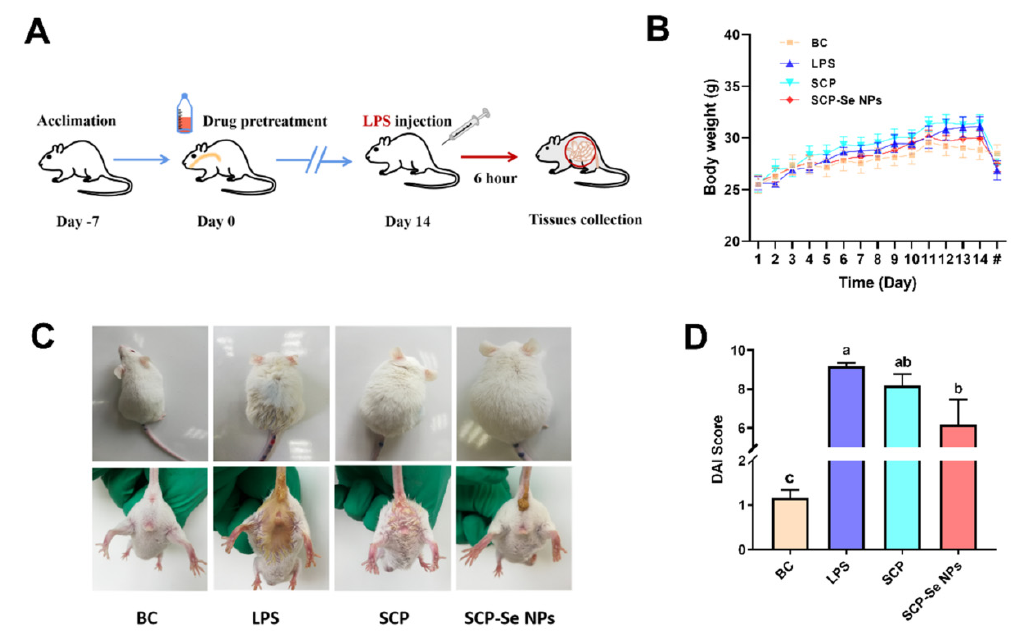
Figure 8. Effects of SCP-Se NPs on LPS-induced enteritis in mice. ( A ) Flow chart of animal experiment. ( B ) Body weight changes of each group during the experiment. “#” indicates the time point of 6 h post-LPS injection. ( C ) Hair and diarrhea in mice after different treatments. ( D ) DAI scores in each group. Different lowercase letters (a–c) indicate significant differences ( p < 0.05).